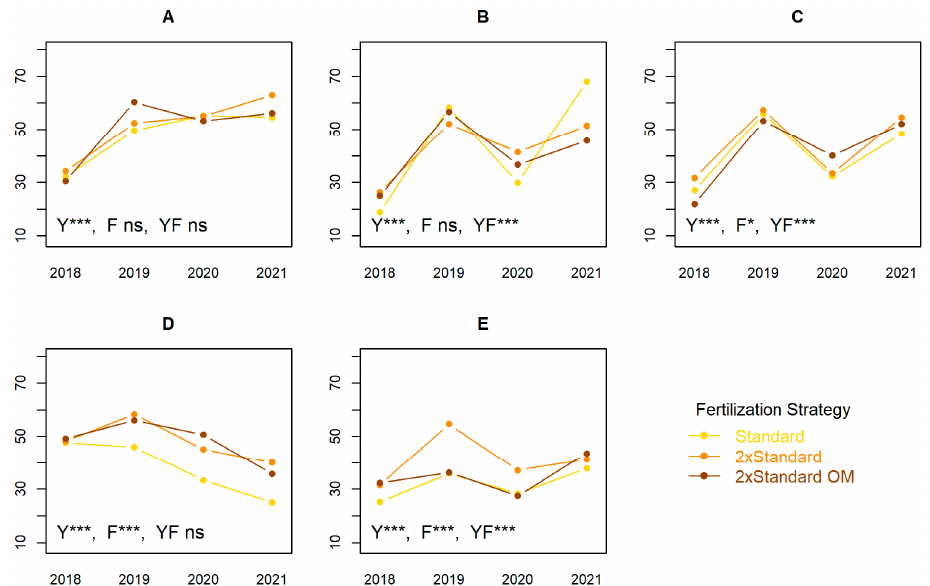
Figure 4. Productivity (t ha − 1 ) of orchards ( A – E ). Each plot refers to an orchard. Each dot represents the average of 15 replicates (apple trees) observed for a given year and fertilization strategy. Lines join points with the same fertilization strategy. An ANOVA model with 2 factors (Year and Fertilization strategy) with interaction was fitted to the data of each plot. The significance of each F-test is also represented. Y: year, F: fertilization strategy, YF: interaction. “***” for p -value < 0.01, “*” for 0.05 < p -value < 0.1 and “ns” for p -value > 0.1.